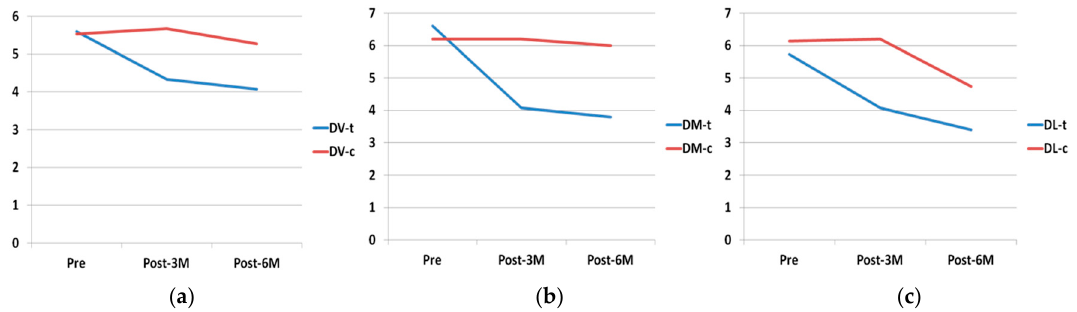
Figure 13. Evolution of PD on DV ( a ), DM ( b ), DL ( c ) surfaces. t: test; c: control.